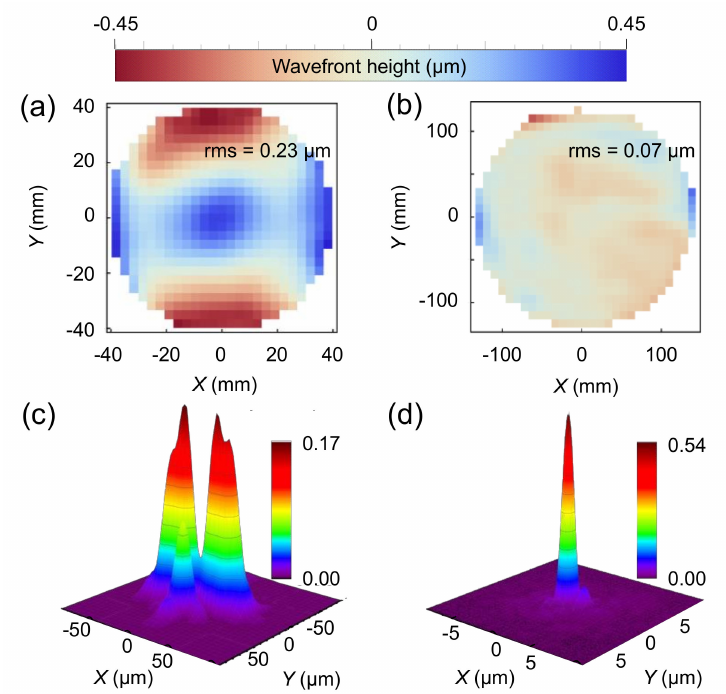
Figure 8. Representative J-KAREN-P laser wavefronts and corresponding calculated and measured spots. ( a ) Wavefront before the deformable mirror for a ~90-mm-diameter beam. ( b ) Wavefront before the compressor for a ~280-mm-diameter beam after aberration correction. ( c ) Calculated spot (PSF) corresponding to frame ( a ). ( d ) Measured at-focus spot (300 TW 280-mm-diameter beam after compressor attenuated with 10 wedges and focused with an f / 1.3 OAP, measured in vacuum). In ( c , d ), the maxima correspond to the corresponding Strehl